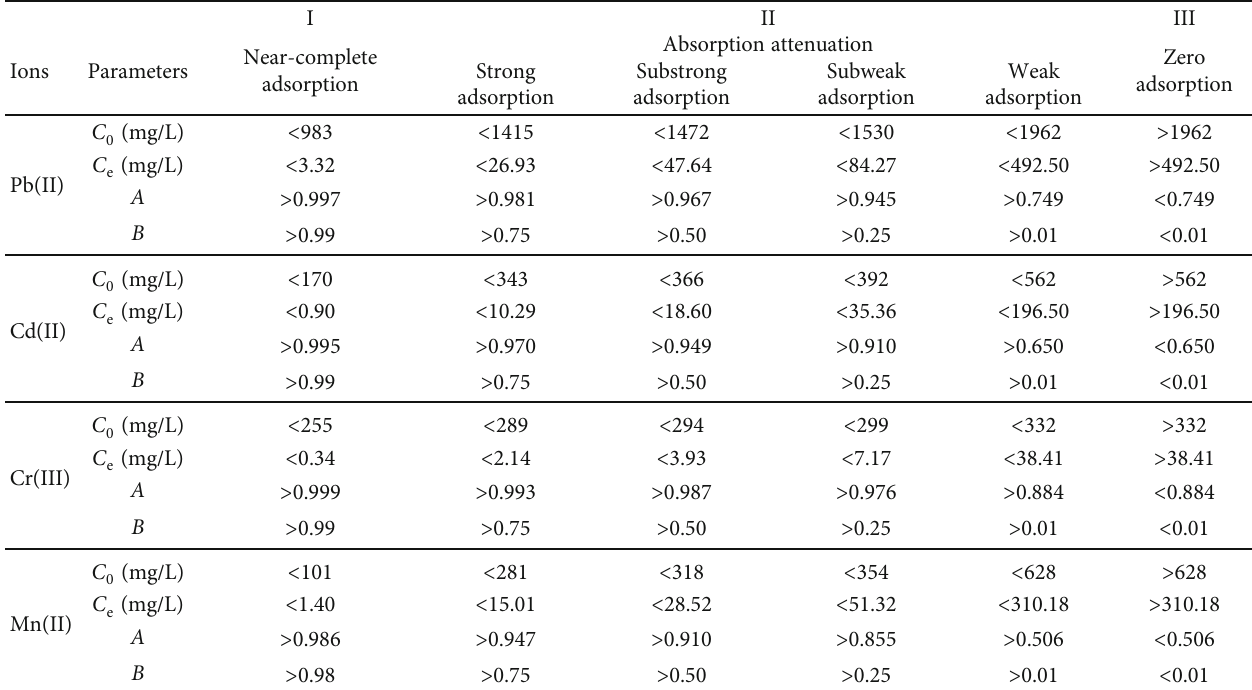
Figure 10: Adsorption curves for heavy metals in the mined-out area. (a) Pb(II), f = 15 . (b) Pb(II), f = 3 ~ 30 . (c) Cd(II), f = 15 . (d) Cd(II), f = 3 ~ 30 Table 4: Ranges of adsorption phases at f = 15